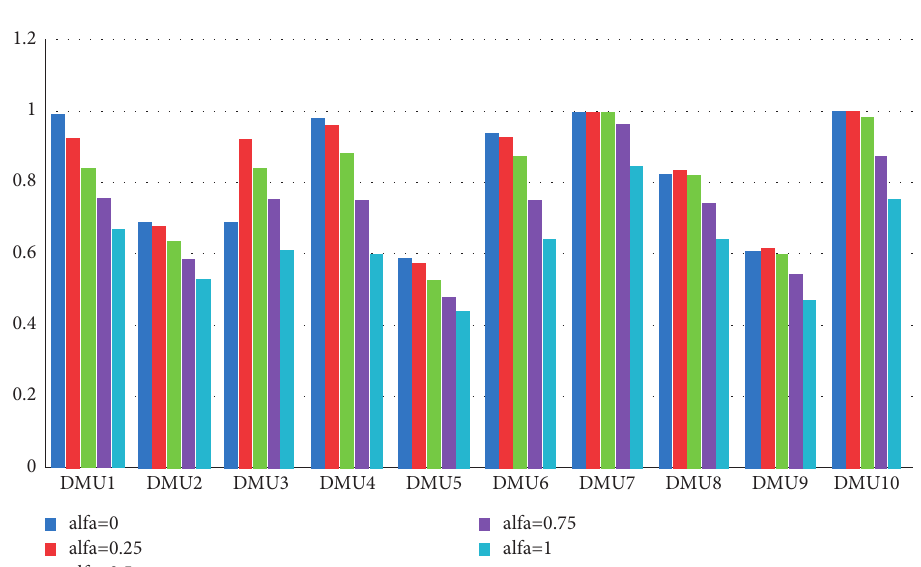
Figure 6: The lower bound of total efficiency at different α -cut